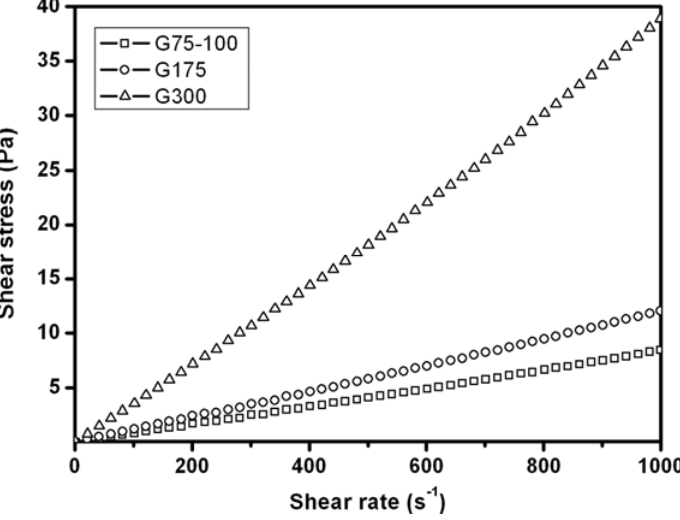
Figure 1. Shear stress versus shear rate curves for various gelatin samples in BSS at 37 °C.